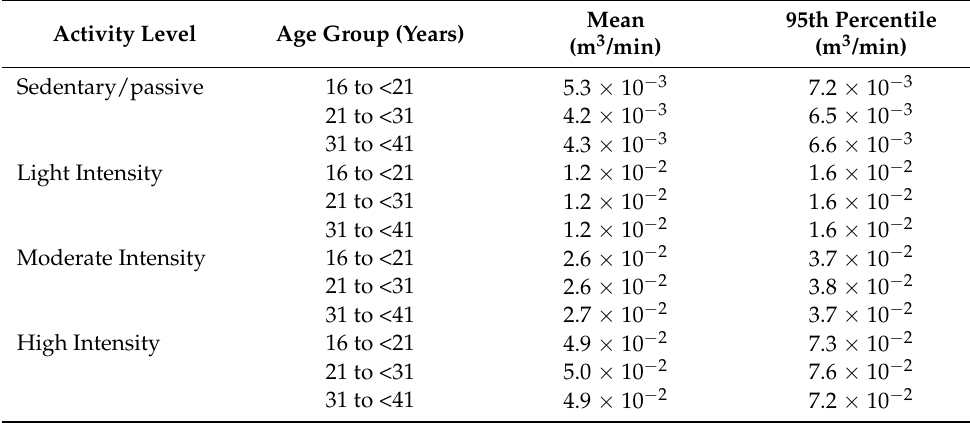
Table 2. Average daily inhalation rates for Short-Term Exposure